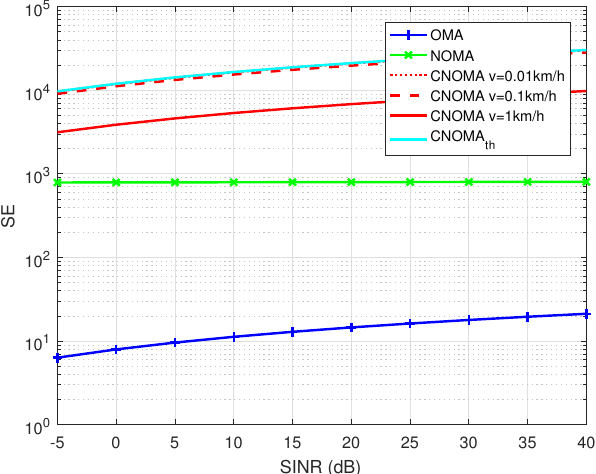
Figure 5. SE comparison between OMA, NOMA and proposed cooperative NOMA. N = 1566 and M = 60.